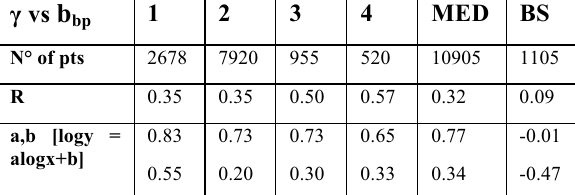
Table 2. Results of correlation coefficients and linear fit parameters ( a, b of logY= a logX+ b ) between γ and and γ along the bp